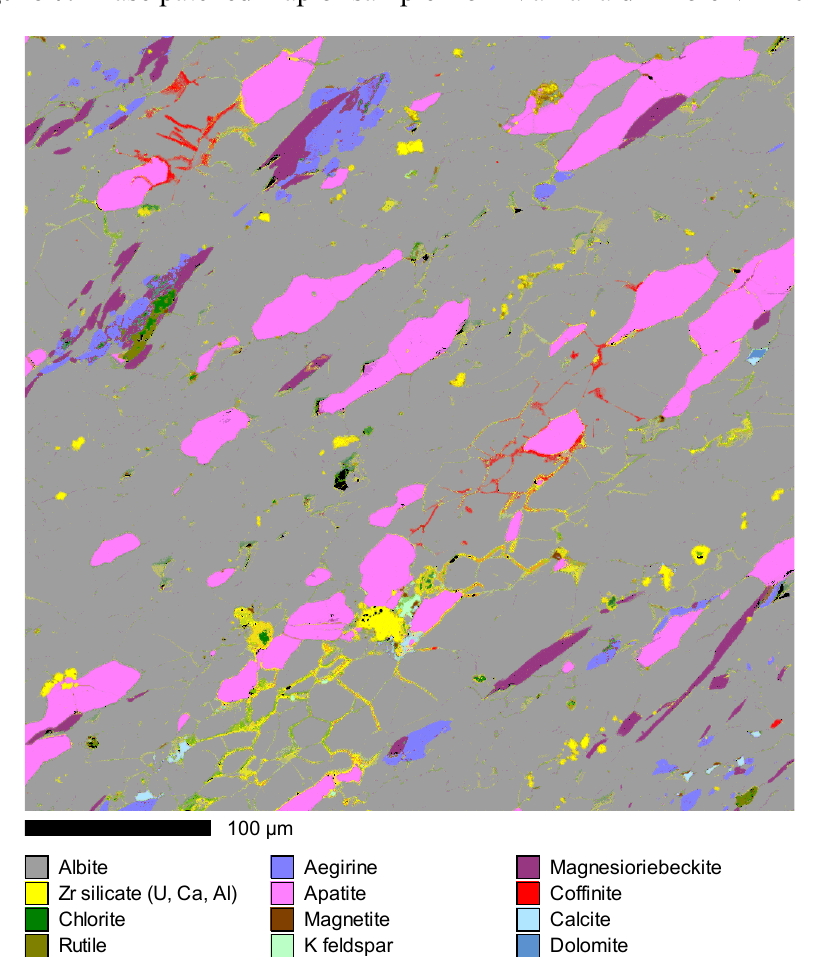
Figure 7. Phase patched map of sample from Valhalla drillhole